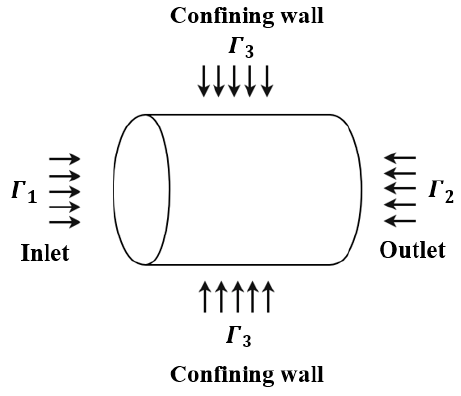
Figure 3. Boundaries in the numerical model.